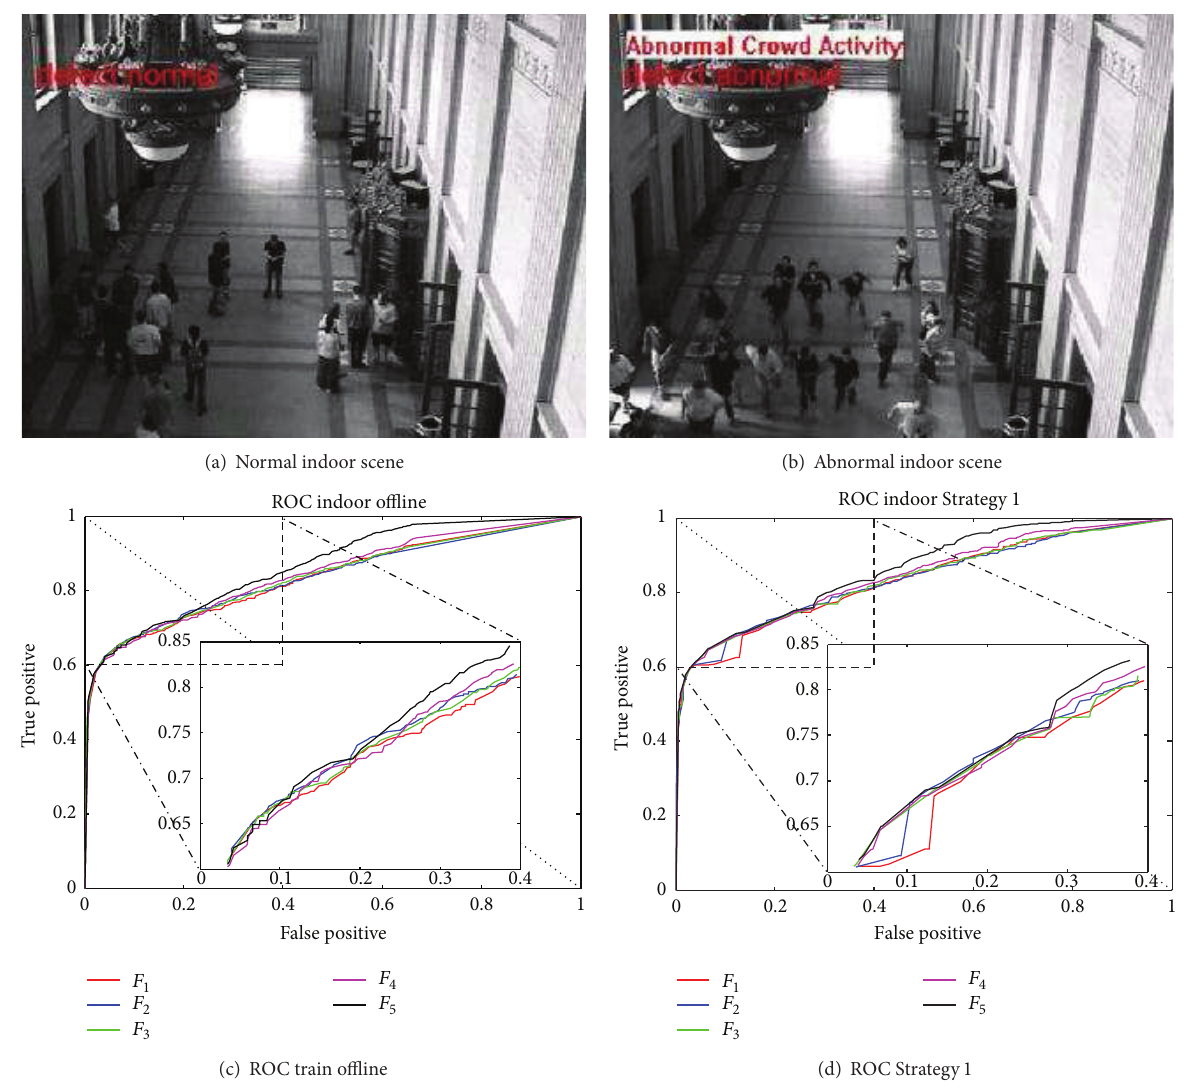
Figure 6: Detection results of the indoor scene. (a) The detection result of one normal frame. (b) The detection result of one abnormal panic frame. (c) ROC curve of different features 𝐹 of the indoor scene results via one-class SVM. All the training samples are learned together offline. The biggest AUC value is 0.8649. (d) ROC curve of different features 𝐹 results via Strategy 1 online one-class SVM. The biggest AUC value is 0.8628.